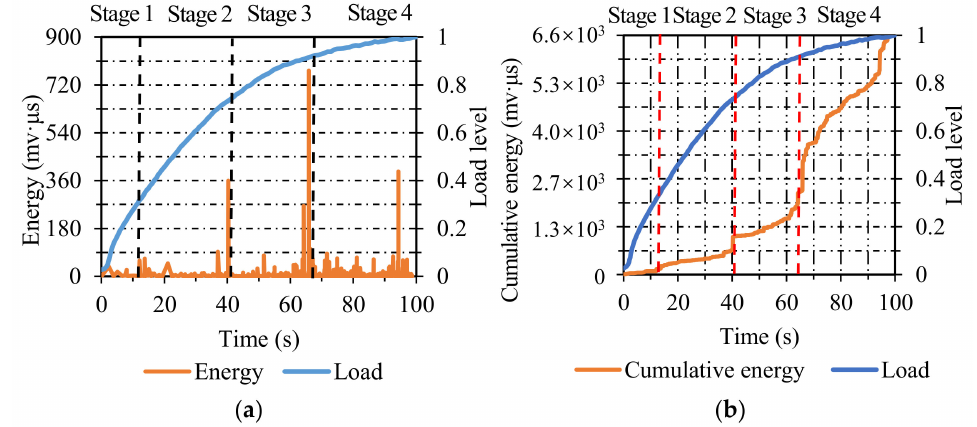
Figure 8. The energy and cumulative energy distribution of OGFC: ( a ) energy; ( b ) cumulative energy.